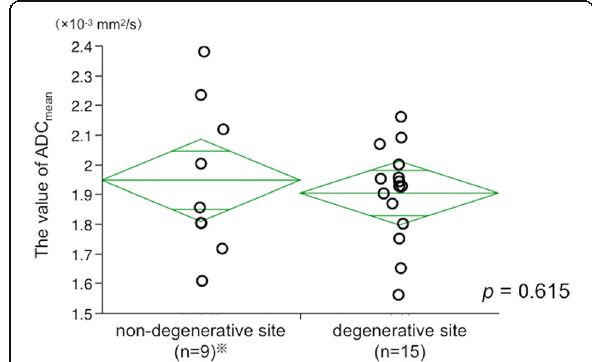
Fig. 3 The average values of ADC mean were almost the same between the degenerate (1.90±0.17×10 − 3 mm 2 /s) and the non-degenerate